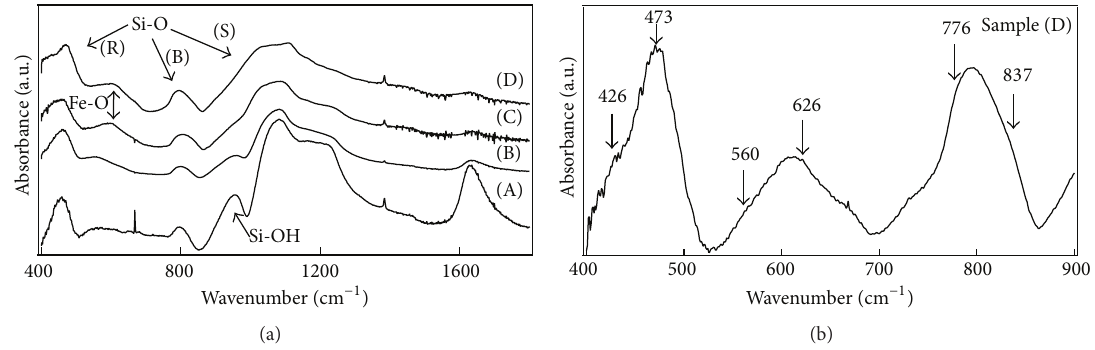
Figure 3: IR spectra of nickel ferrite-SiO 2 at (a) different heat treatment temperatures and (b) IR spectra in the range from 400 to 900 cm −1